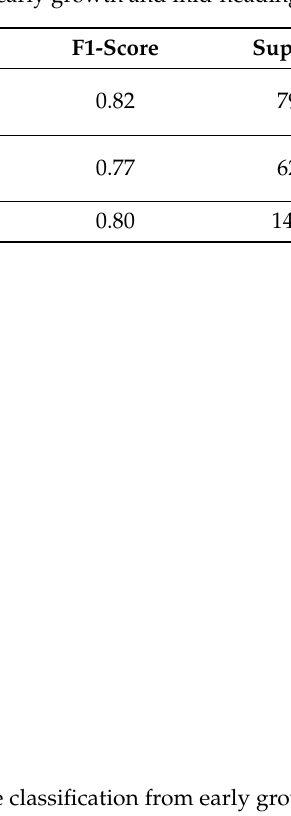
Figure 25. The confusion matrix of the cabbage growth stage classification from early growth and mid-heading stages.